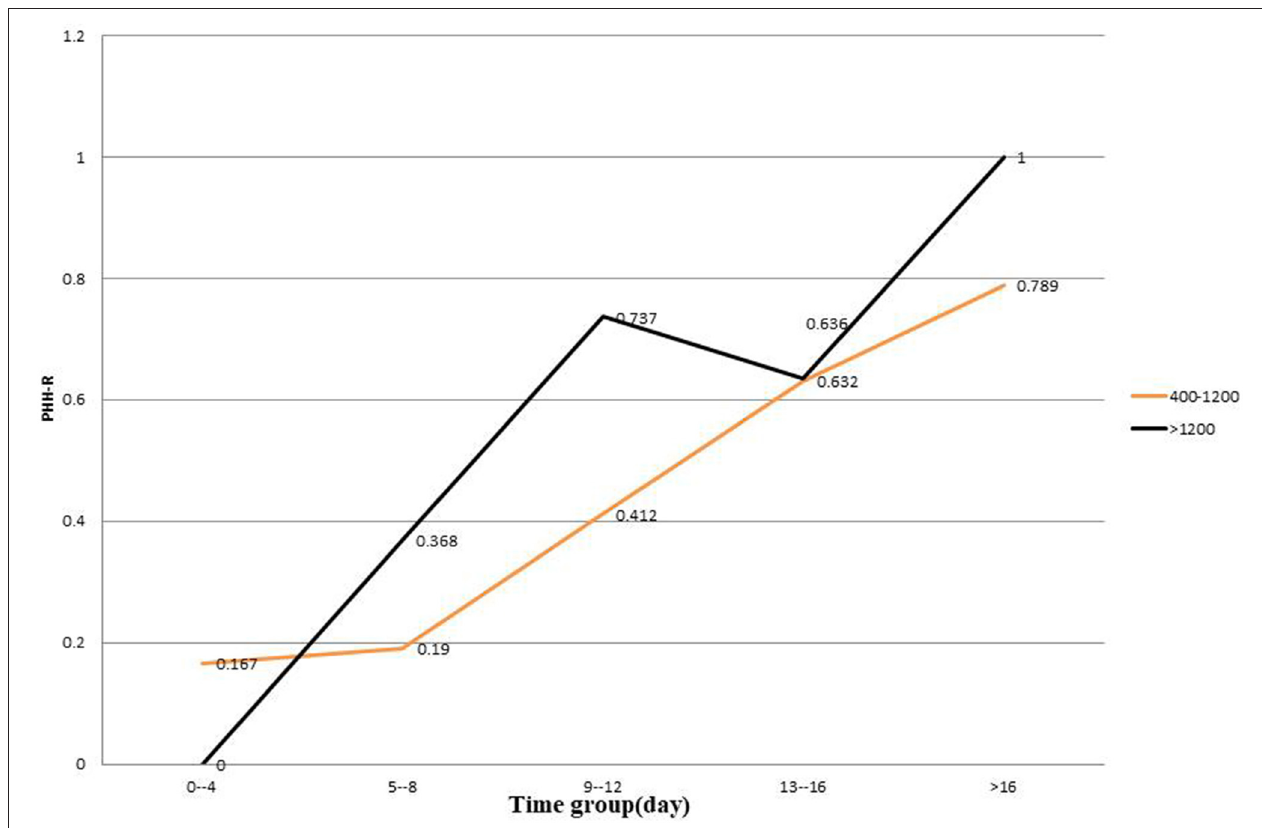
FIGURE 4 | PHH-R in 400–1,200 group and > 1,200 group. PHH-R, Rate of posthemorrhagic hydrocephalus.